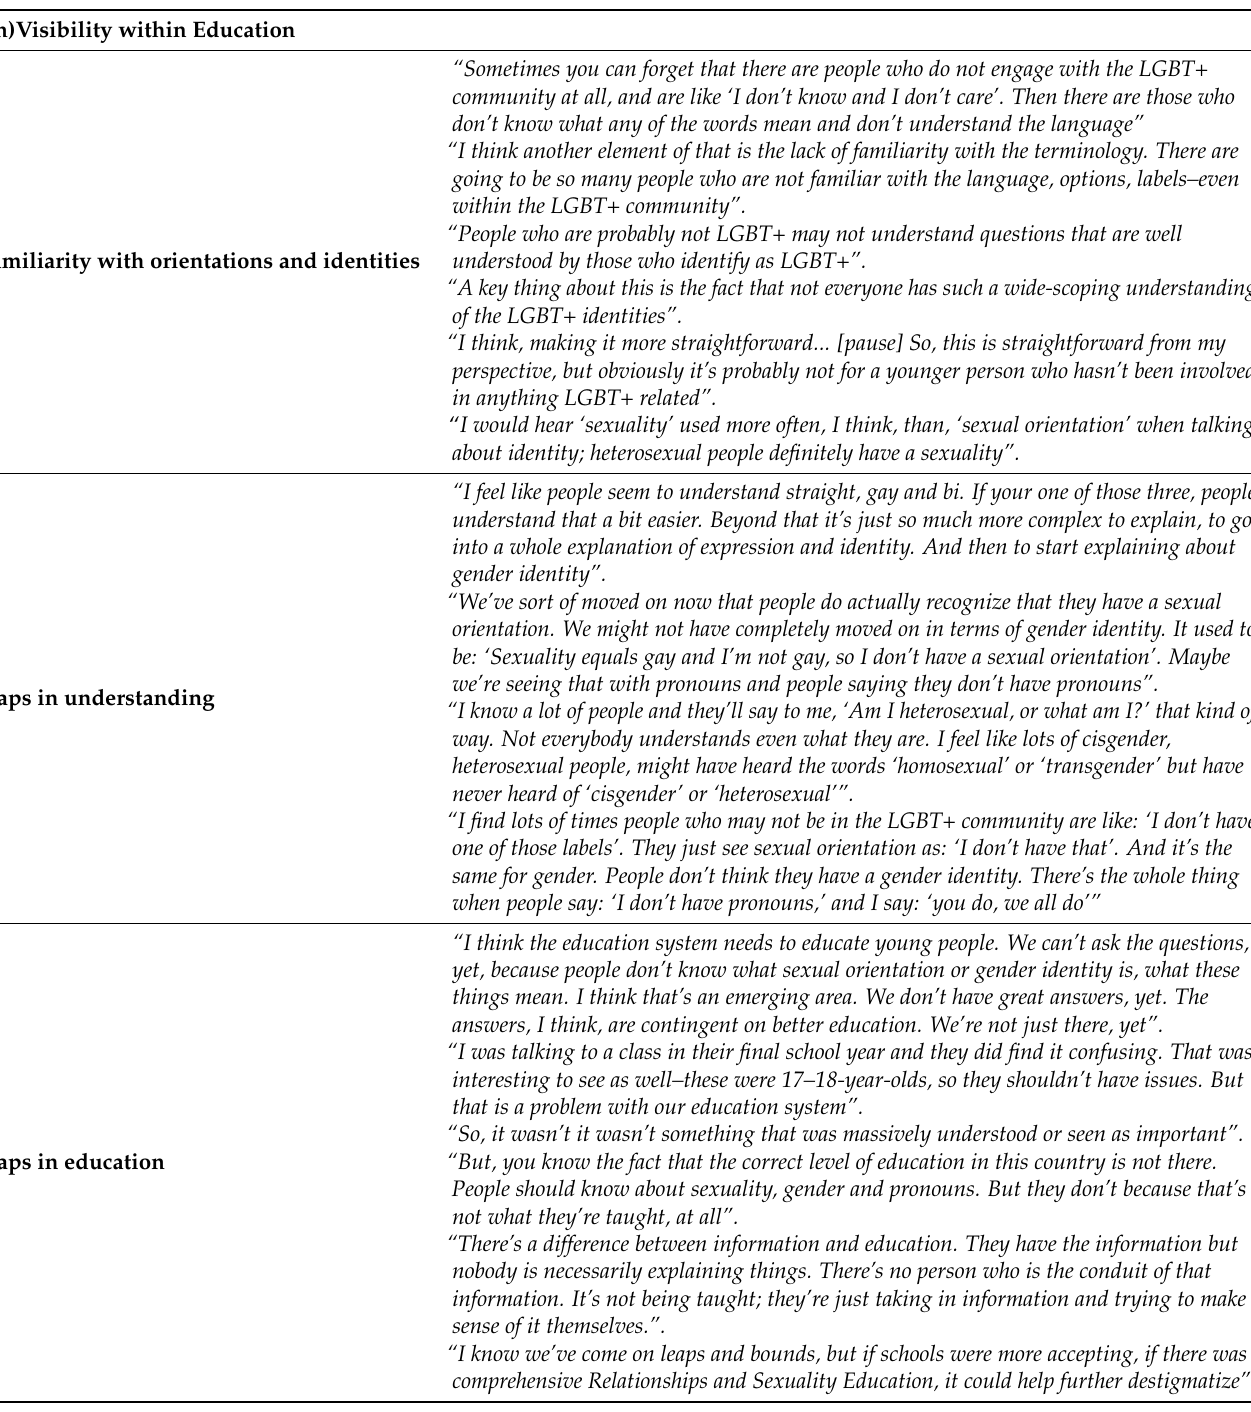
Table 5. Youth co-authors reflections on the silence and (in)visibility of LGBT+ identifications and orientations within